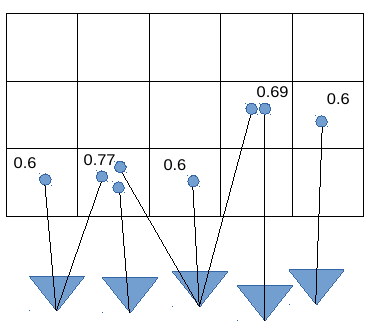
Figure 3. Assuming an inlier probability of 60% for individual points, overall inlier probabilities of 69% (two points) and 77% (three points) follow considering BBF.